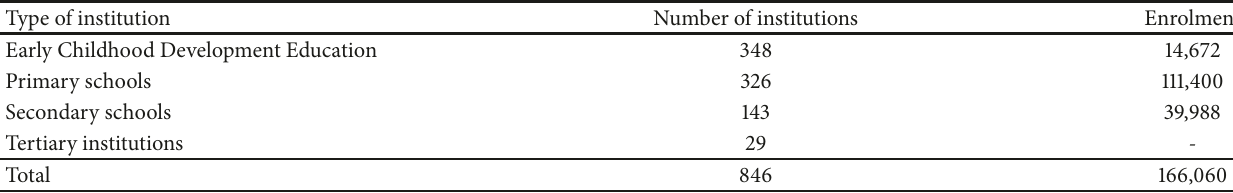
Table 3: Number of educational institutions in